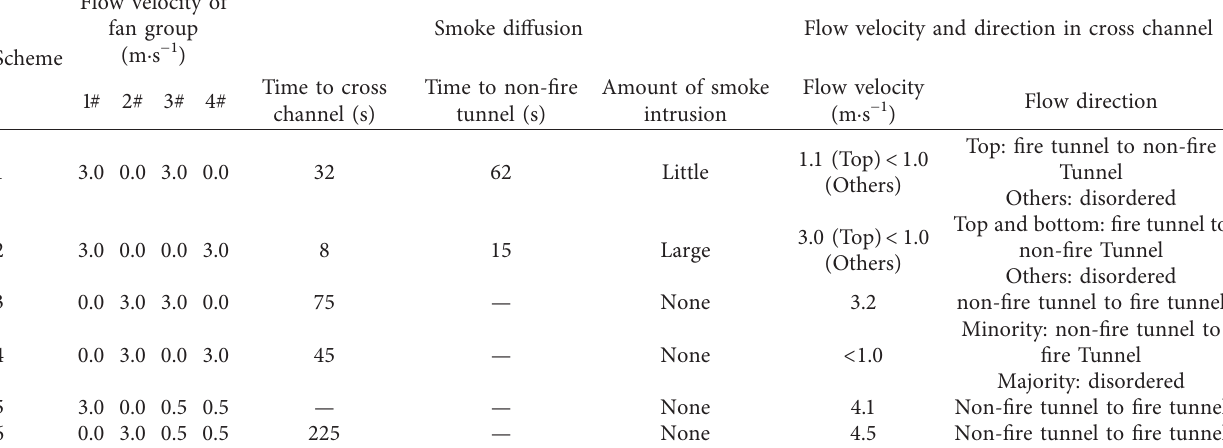
Table 2: Summary of linkage control schemes for ventilation